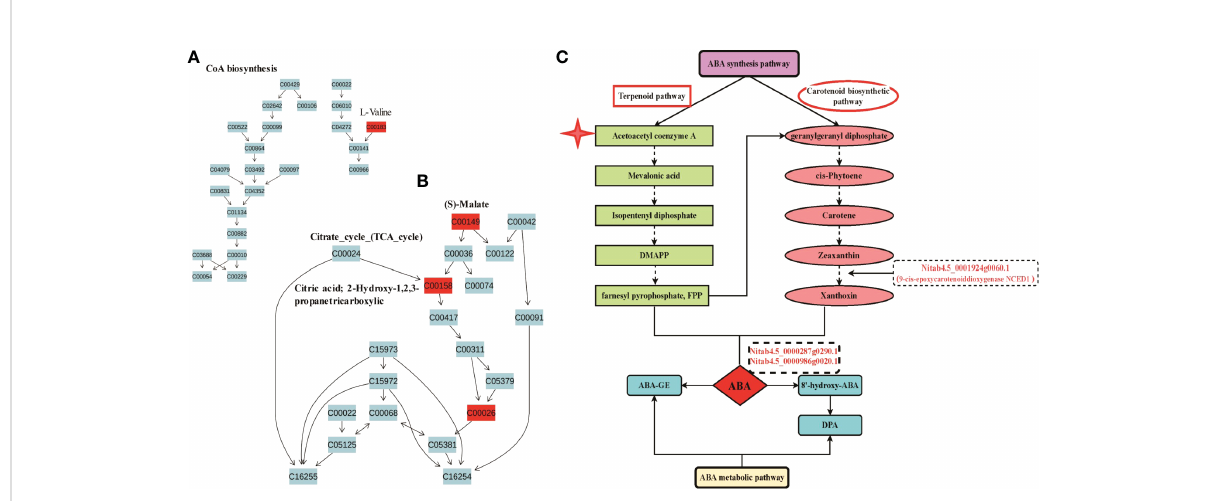
FIGURE 6 Involvement of Abscisic acid in drought responses in tobacco. (A) Overview of the KEGG pathway of CoA biosynthesis. The red indicating signi fi cantly up-regulated metabolites between M28 and K326 after drought treatment. (B) Overview of the KEGG pathway of Citrate cycle (TCA cycle). The red indicating signi fi cantly up-regulated metabolites between M28 and K326 after drought treatment. (C) Involvement of DEGs in combination with metabolites in synthesis and decomposition pathways of Abscisic acid in